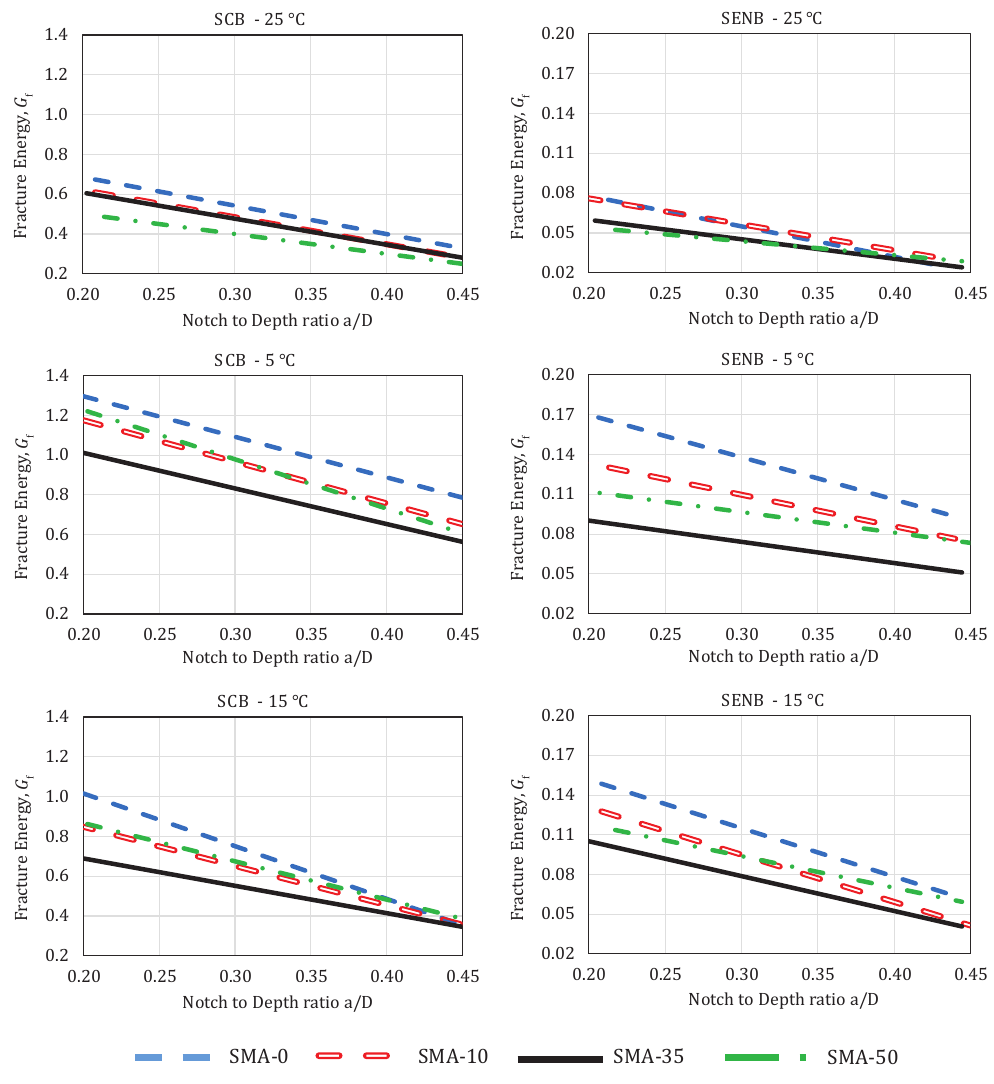
Figure 11. Fracture energy vs. notch depths for varying